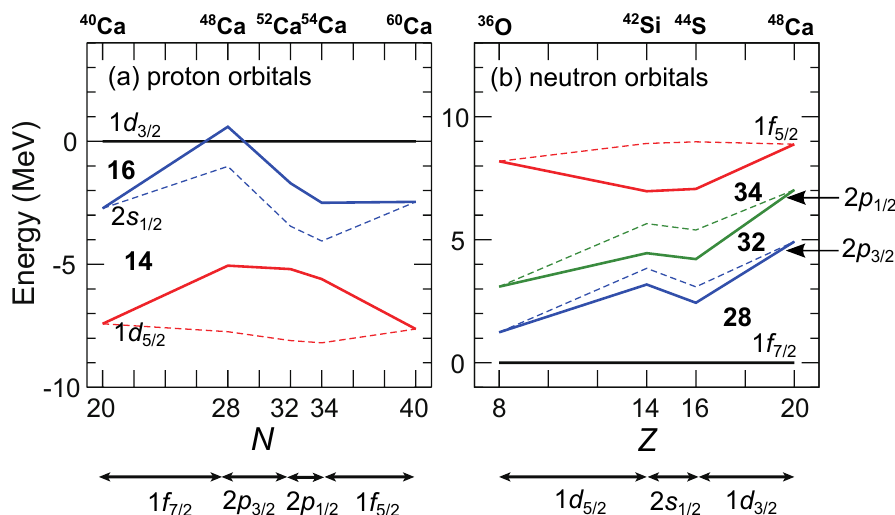
Figure 2. Evolution of the ESPEs calculated with the SDPF-MU interaction with the tensor force included (solid lines) and not included (dashed lines). ( a ) Proton orbitals measured from 1 d 3/2 for the atomic number Z = 20 isotopes and ( b ) neutron orbitals measured from 1 f 7/2 for the neutron number N = 28 isotones. The ESPEs are obtained by assuming filling configurations whose orders are indicated at the bottom of the